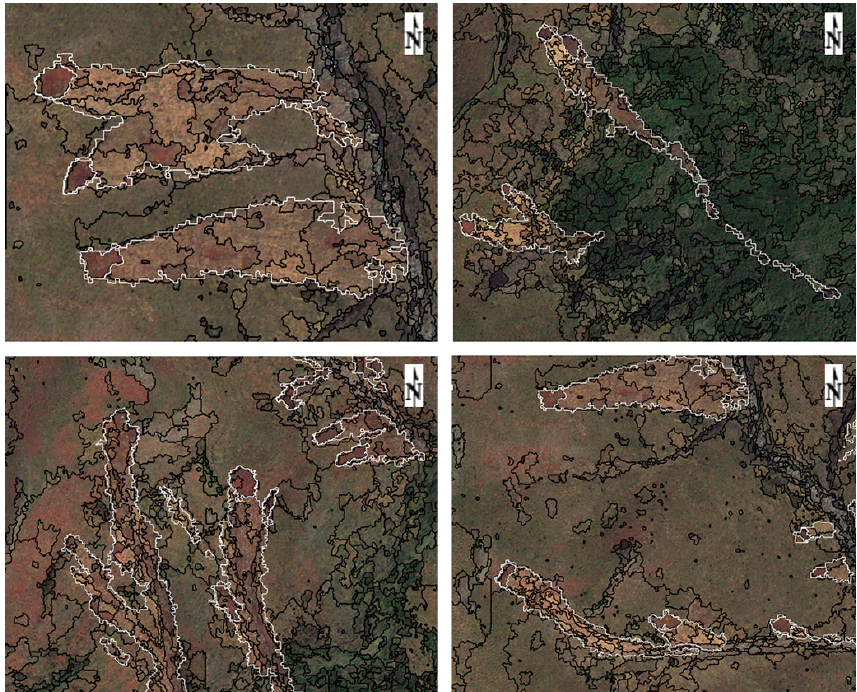
Figure 4. Details of GeoEye-1 pan-sharpened RGB image, showing the partition segments resulting from the chosen segmentation/merging parameters: scale 40, merge 90; white contour is the inventory landslide delineation; black contour is the image partition. Table 1. Layers used in